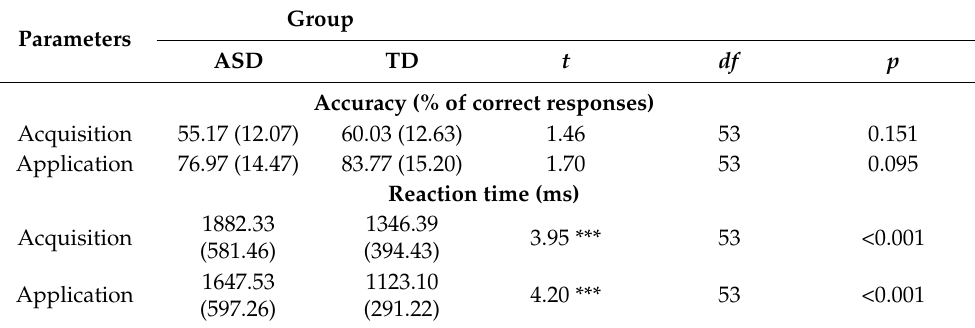
Table 2. WCST behavioral performance.